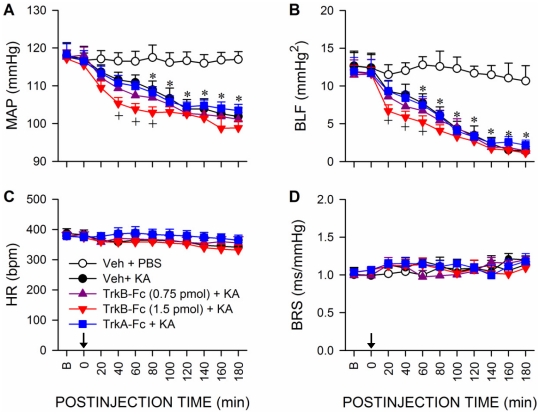
Upregulation of TrkB in RVLM ameliorates the reduced baroreflex-mediated sympathetic vasomotor tone during experimental TLSE.Temporal changes in MAP (A), power density of the BLF component (B), HR (C) or BRS (D) after microinjection of KA (0.5 nmol) or PBS into the left hippocampal CA3 subfield (at arrow) of animals that received pretreatment by application into the bilateral RVLM of 0.1 M PBS (Veh), TrkB-Fc (0.75 or 1.5 pmol) or TrkA-Fc (1.5 pmol). Values are mean ± SEM from 5–7 animals per experimental group.*P<0.05 versus Veh+PBS group, and +
P<0.05 versus Veh+KA group at corresponding time-points in the post hoc Scheffé multiple-range test. B = preinjection baseline.